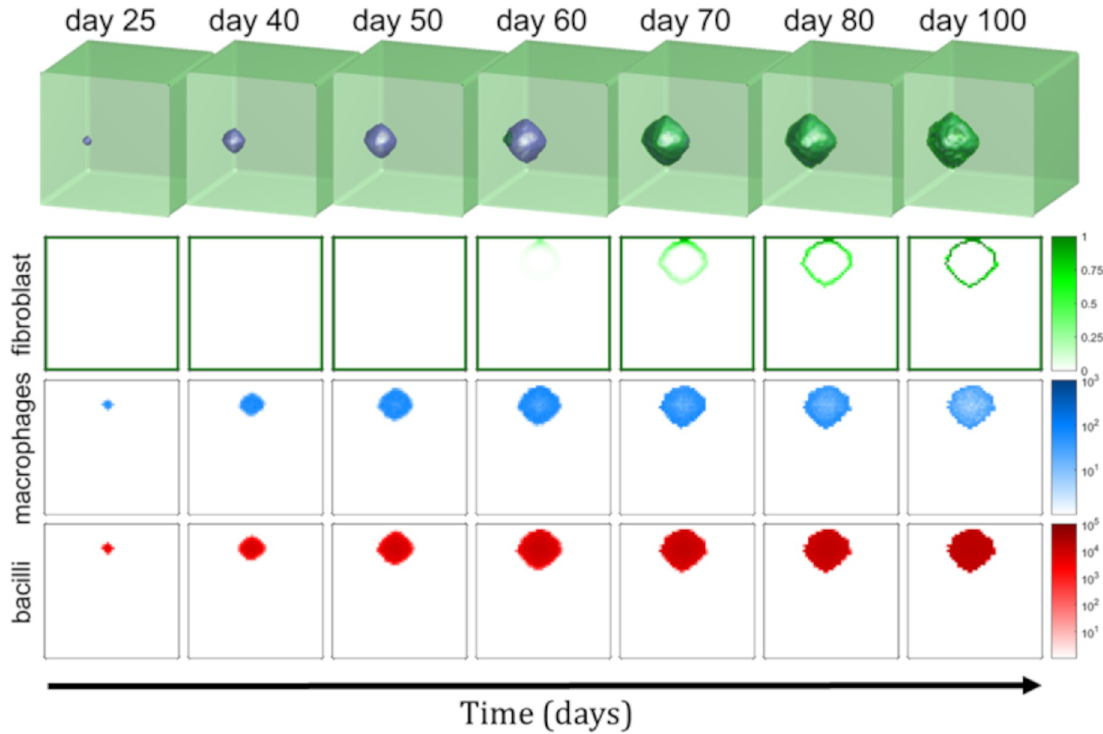
Fig 6. Evolution of 3D model. Evolution of the secondary lobule model in a cubic 50 × 50 × 50 alveoli grid. The first row is the 3D representation of the secondary lobule. Fibroblasts are shown in green and the occupied space (macrophages, T cells, dead cells, bacilli ... ) is in blue. Second, third and fourth rows represents a slice (z plane at the height of initial infection). Concentration of fibroblasts in shown in green (second row), the total number of macrophages (uninfected, infected and activated) in logarithmic scale in blue (third row) and, finally, the total number of bacilli (intracellular and extracellular) in logarithmic scale in red (fourth row). These quantities and representations can be observed at different days after initial infection, each column represents a different time of simulation.